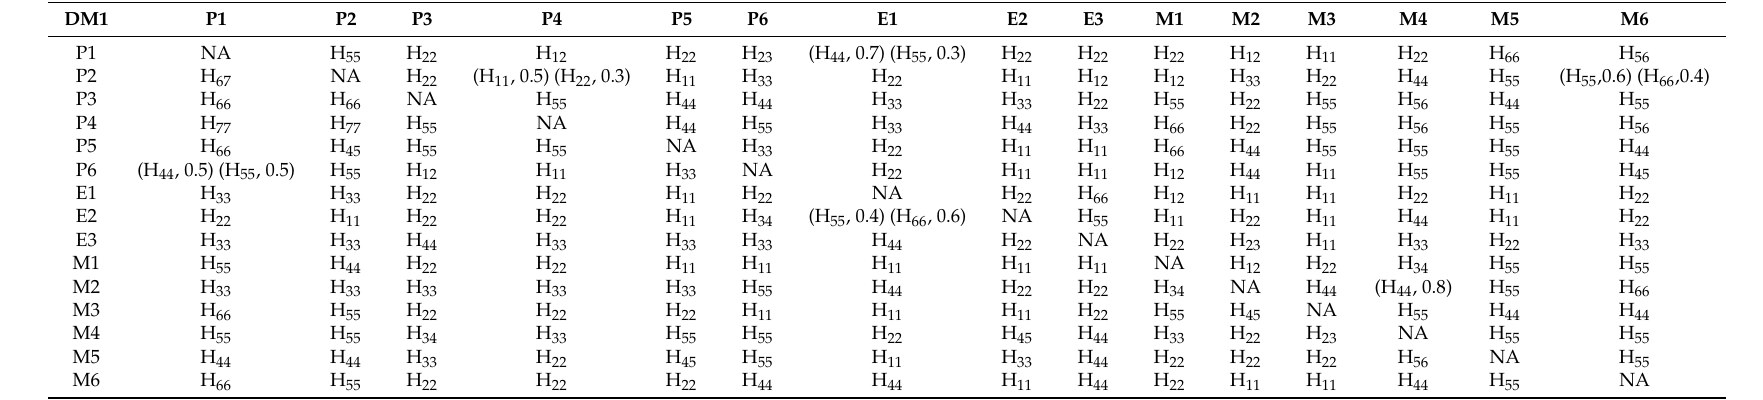
Table 2. Initial direct-influence matrix of the first expert.